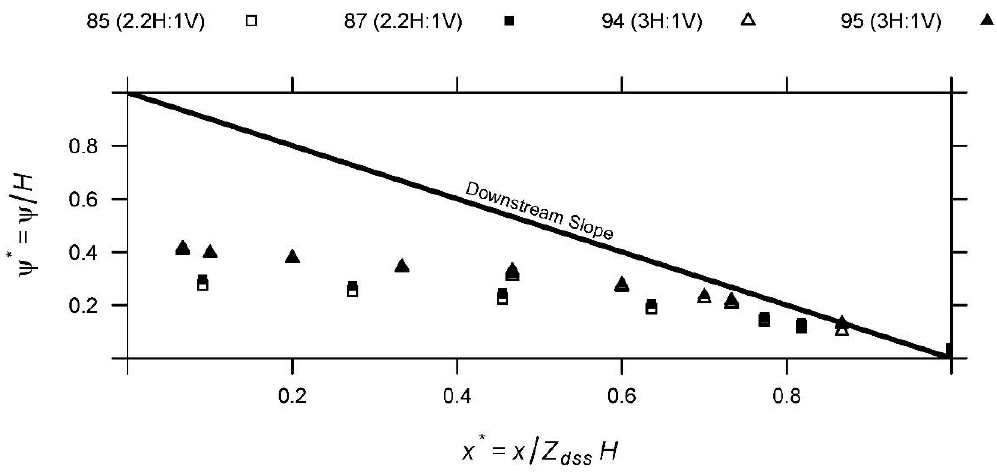
Figure 8. Hydraulic pressures measured for roughly the same discharge in tests nº 85 and 87 C) and n o 94 and 95 (Group E). These pressures correspond to discharges of 0.0051 m 3 s − 1 and (Group C) and nº 94 and 95 (Group E). These pressures correspond to discharges of 0.0067 m 3 s − 1 in tests 85 and 87, respectively, and of 0.0071 m 3 s − 1 and 0.0072 m 3 s − 1 in tests 94 0.0051 m 3 s −1 and 0.0067 m 3 s −1 in tests 85 and 87 , respectively, and of 0.0071 m 3 s −1 and and 0.0072 m 3 s −1 in tests 94 and 95 .